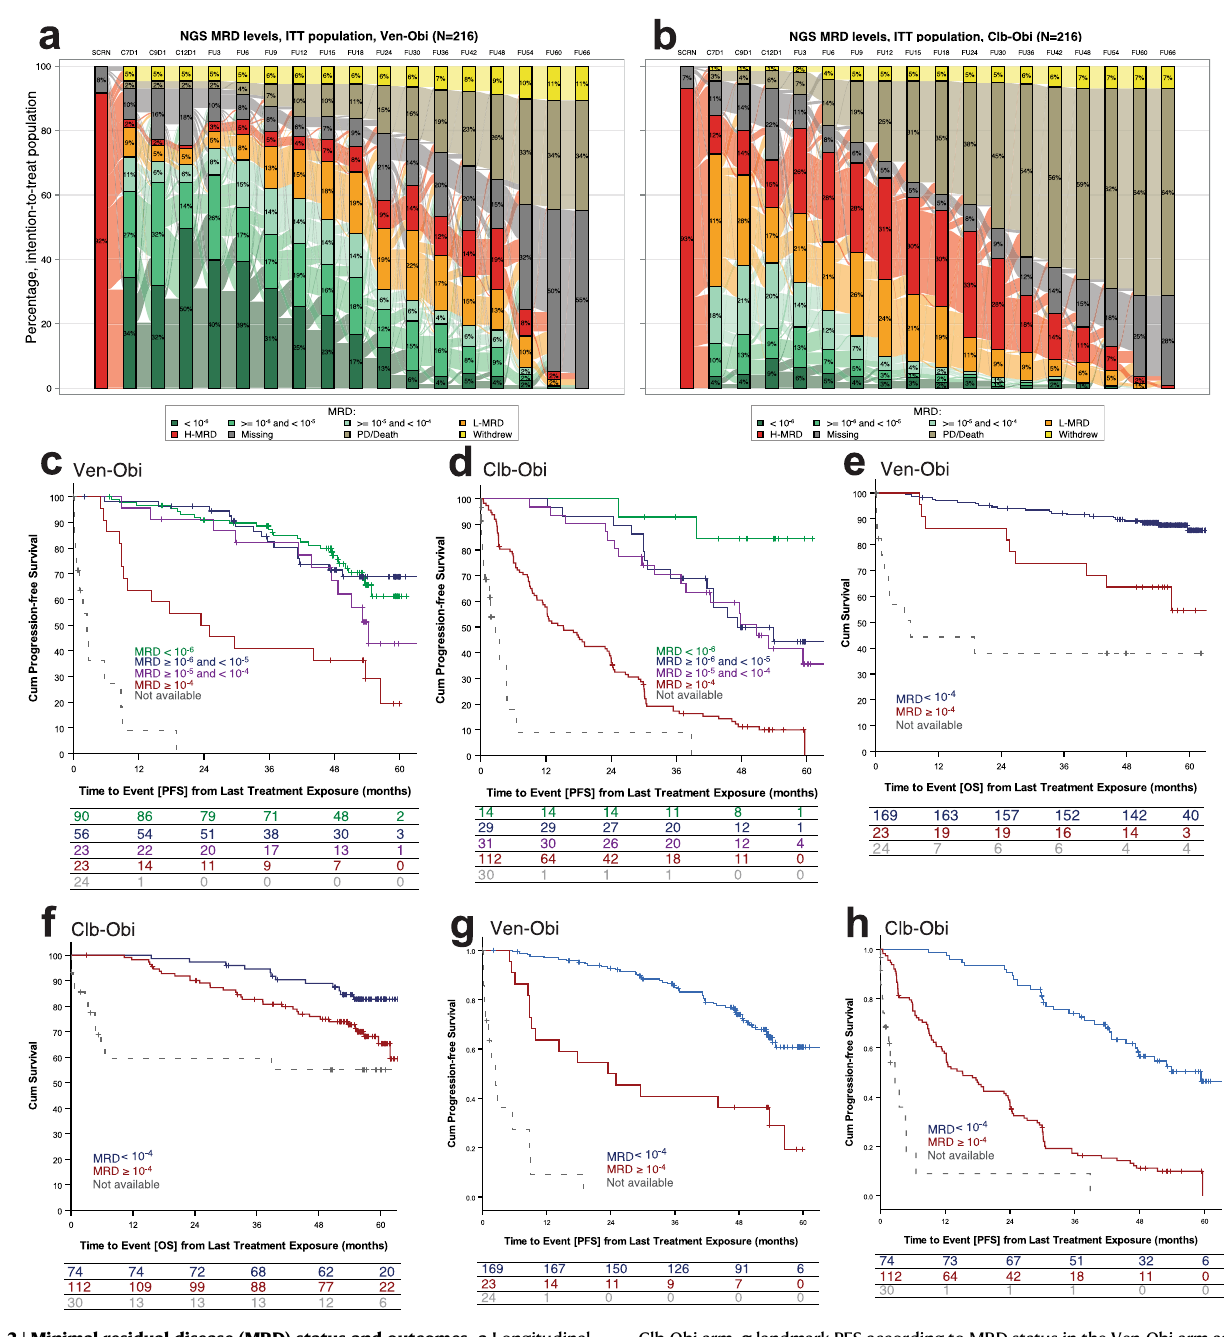
Clb-Obi arm, g landmark PFS according to MRDstatus in the Ven-Obi arm and h in theClb-Obiarm; ‘ Notavailable ’ indicatespatientswithoutanendoftreatmentMRD status, due to earlier withdrawal or missing/unevaluable